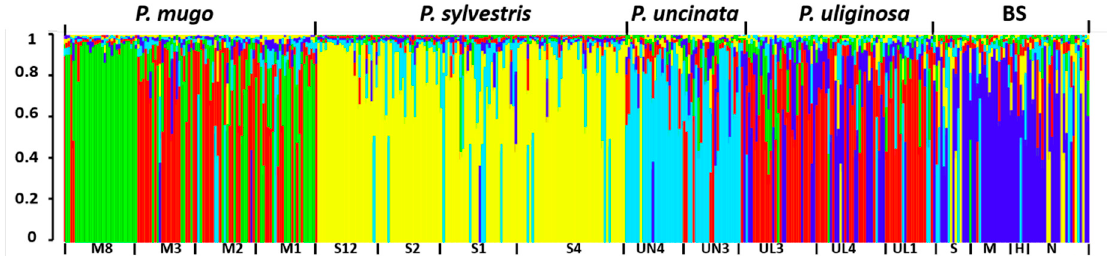
Figure 4. STRUCTURE results indicating five groups of samples based on genetic variation at nSSR loci of the mixed pine population from Bł˛edne Skały (BS) and reference populations of the four pine species (population acronyms as in Table 1).